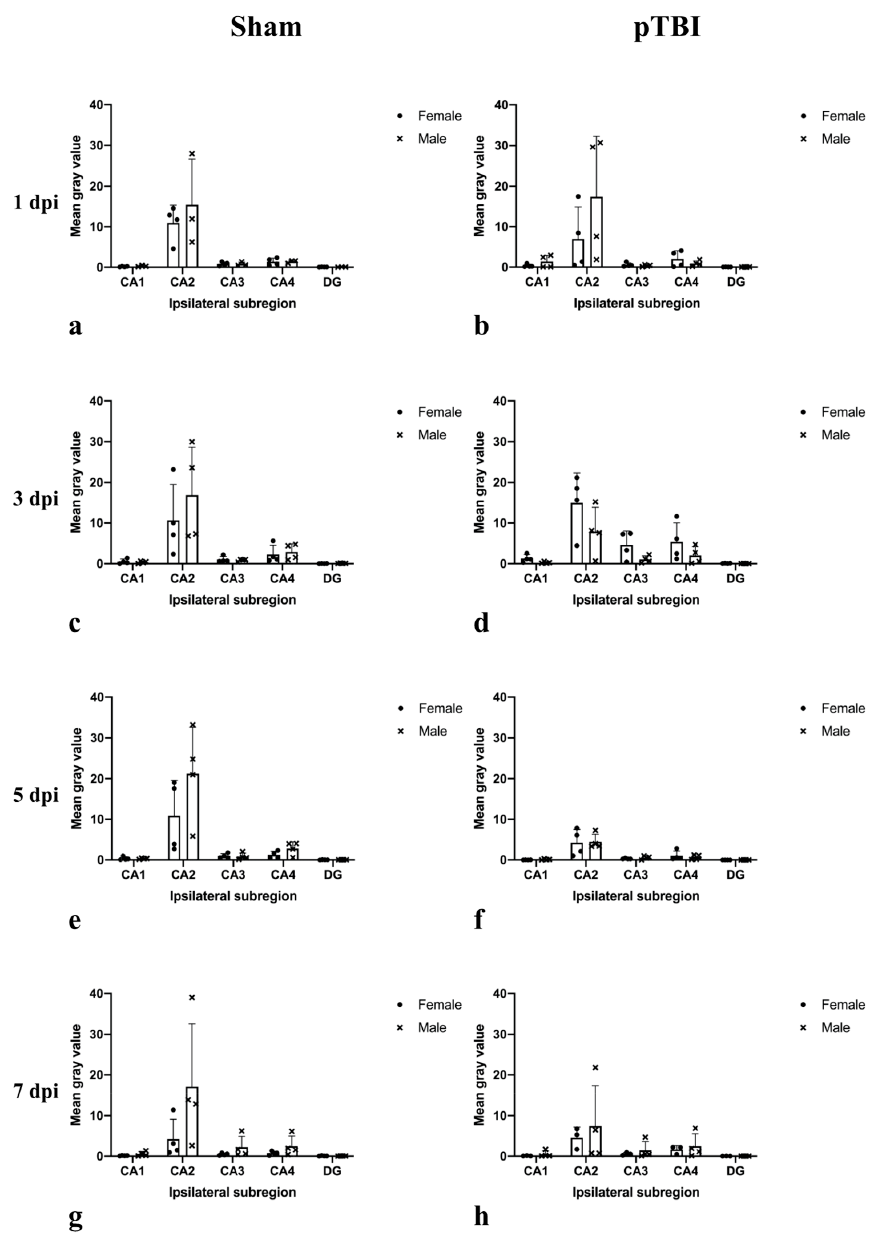
Figure 3. Comparison of male and female hippocampal CYP1B1 mRNA expression in rats subjected to either sham-surgery or pTBI. Animals in Sham received a craniotomy, while animals in pTBI received a craniotomy with a subsequent pTBI. Graphs show mRNA expression 1 dpi in males and females subjected to sham-surgery ( a ), mRNA expression 1 dpi in males and females subjected to pTBI ( b ), mRNA expression 3 dpi in males and females subjected to sham-surgery ( c ), mRNA